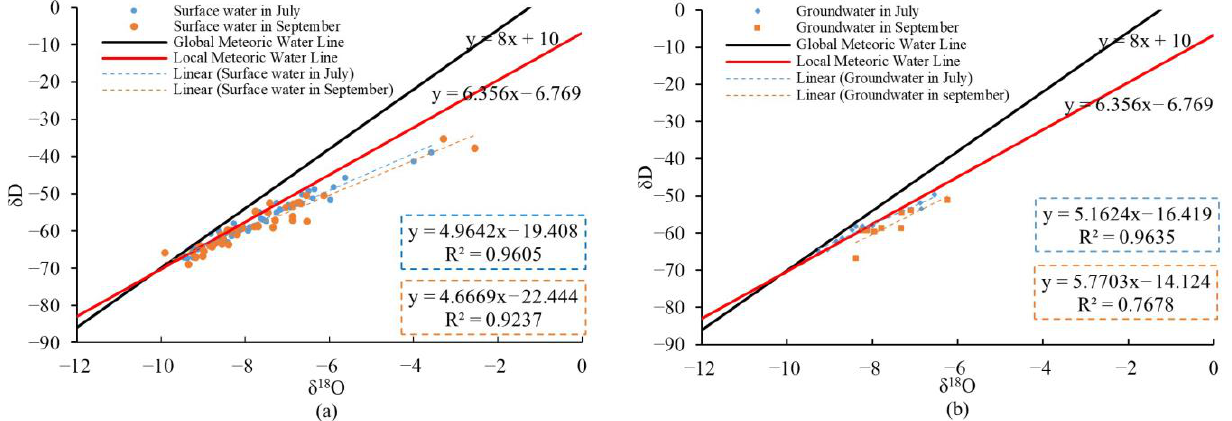
Figure 5. δD and δ 18 O relationship between surface water and groundwater- Meteoric Water Line sampled twice in the Mountainous watershed of Daqing River.